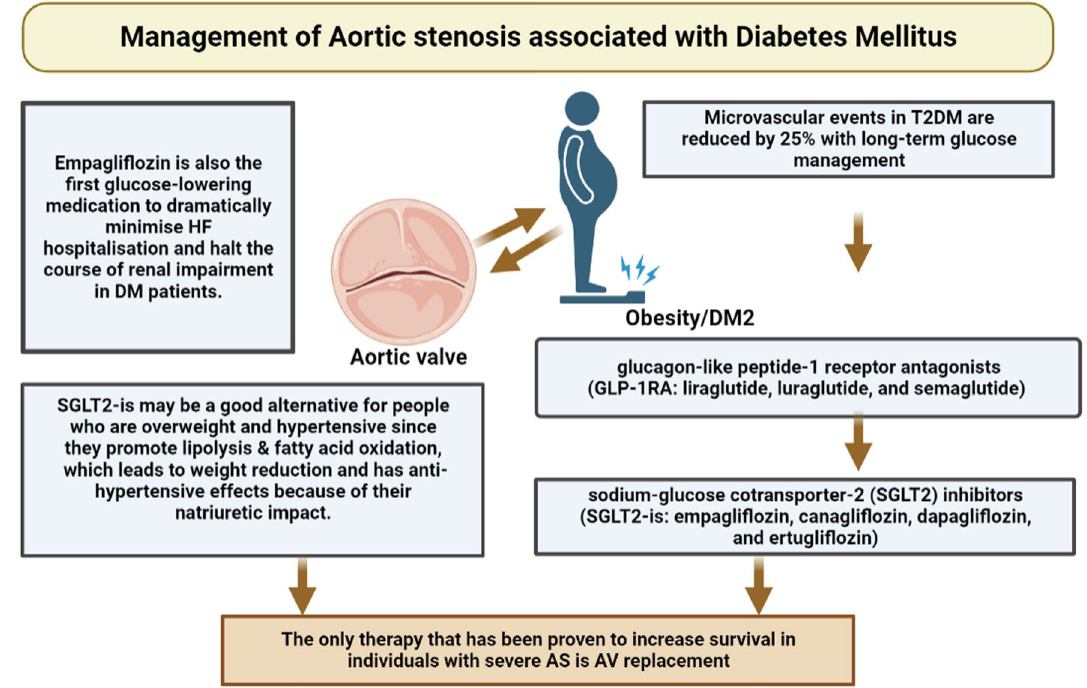
Fig. 6 Diagrammatic representation of management of Aortic Stenosis associated with Diabetes